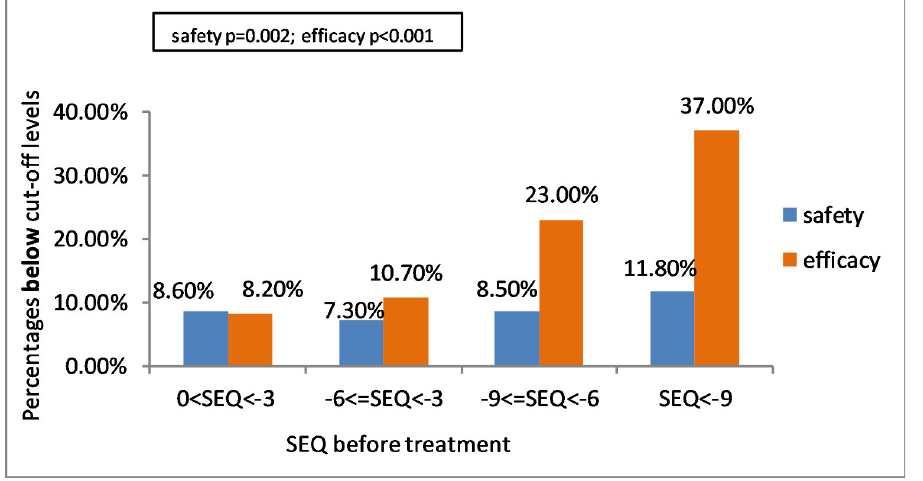
Fig 1. Association between SEQ before treatment and eyes below efficacy and safety cut-off levels using univariate analysis and Pearson Chi-Square test (p = 0.002 for safety, p < 0.001 for efficacy). SEQ = spherical equivalent.